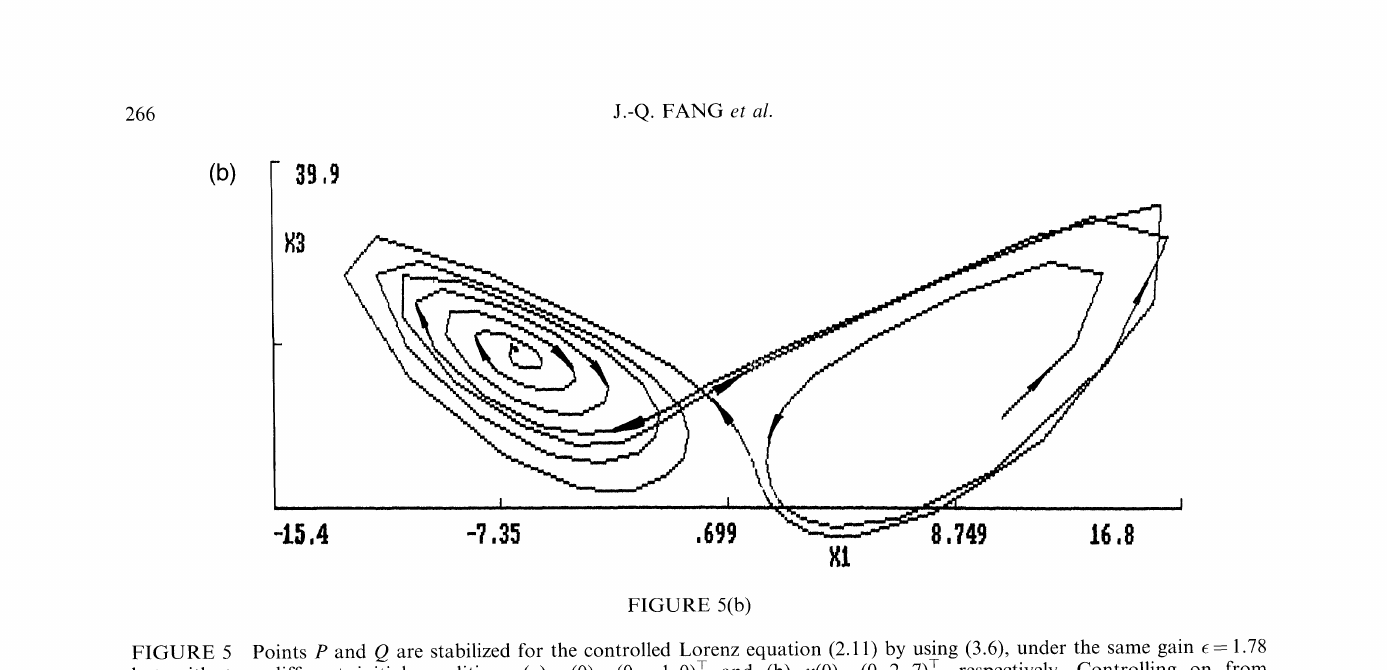
FIGURE 5 Points P and Q are stabilized for the controlled Lorenz equation (2.11) by using (3.6), under the same gain 1.78 but with two different initial conditions (a) x(0) (0, -1, 0) v and (b) x(0)=(0, 2, 7) T= 40000. (a) Projection for controlling to P in the x3-xl plane. (b) Projection for controlling to Q in the x3-xl plane.